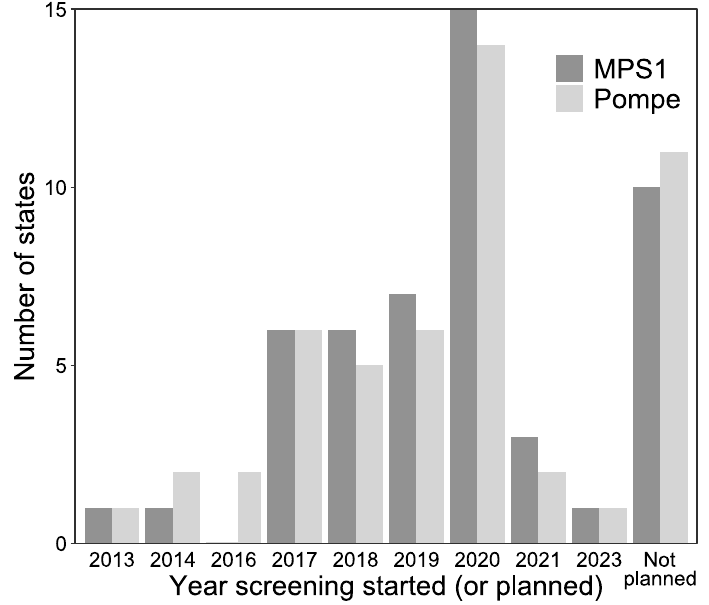
Figure 2. Distribution of when NBS began for MPSI (dark gray) and Pompe disease (light gray) by